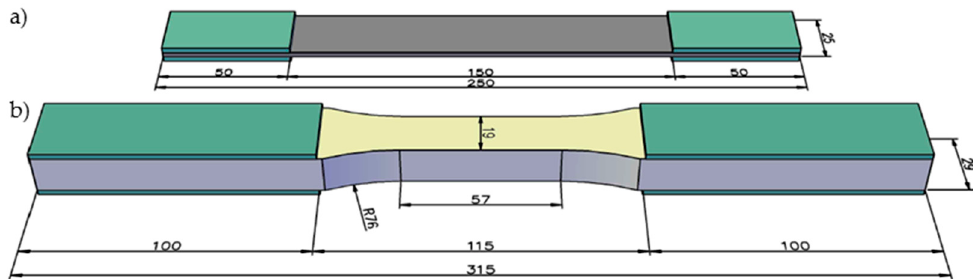
Figure 1. Geometry of typical tensile specimens (dimensions in mm); ( a ) rectangular specimen according to the ISO 527-4 standard; ( b ) dumbbell-shaped specimen according to the ASTM D638 standard.